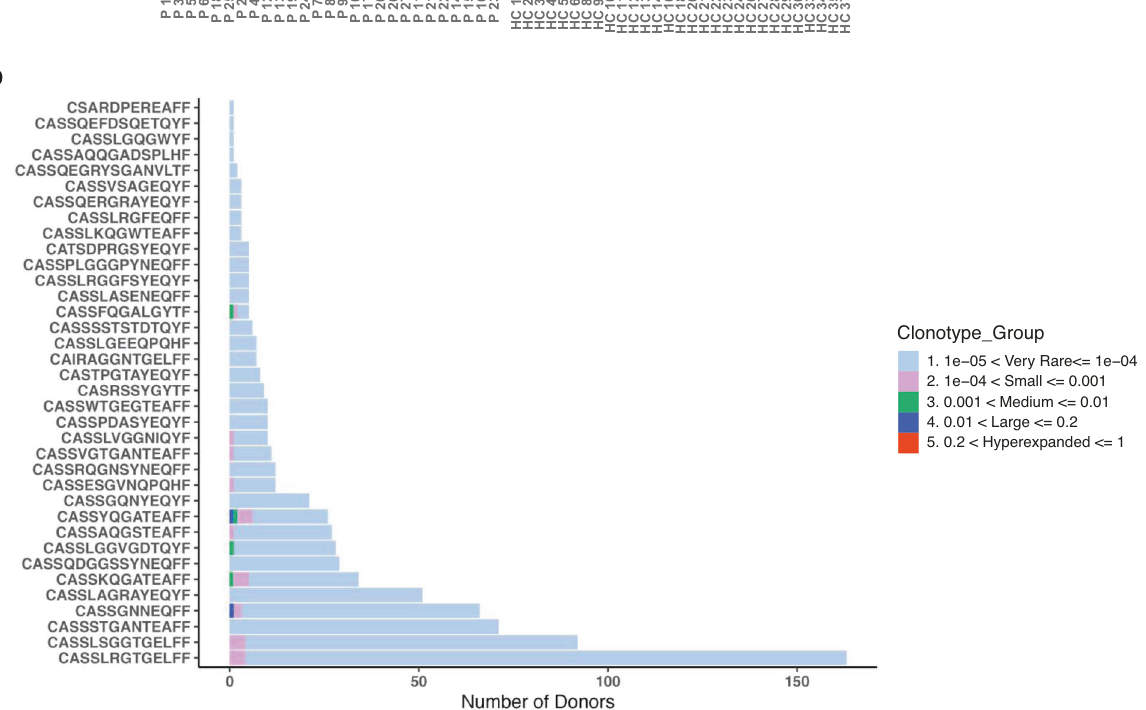
Fig. 5 Publicness of the CD4 + T-LGLL clones. a CD4 + T-LGLL clonotypes are shared between CD4 + T-LGLL patients ( n = 27) and healthy cohort ( n = 37) in extremely rare frequencies. Shared clonotypes are at the bottommost rows and the colors refer to the size of the clonotype. b CD4 + T-LGLL clonotypes found in smaller frequencies in publicly available, unsorted, healthy cohort data ( n = 786) [29] where the colors refer to the size of the